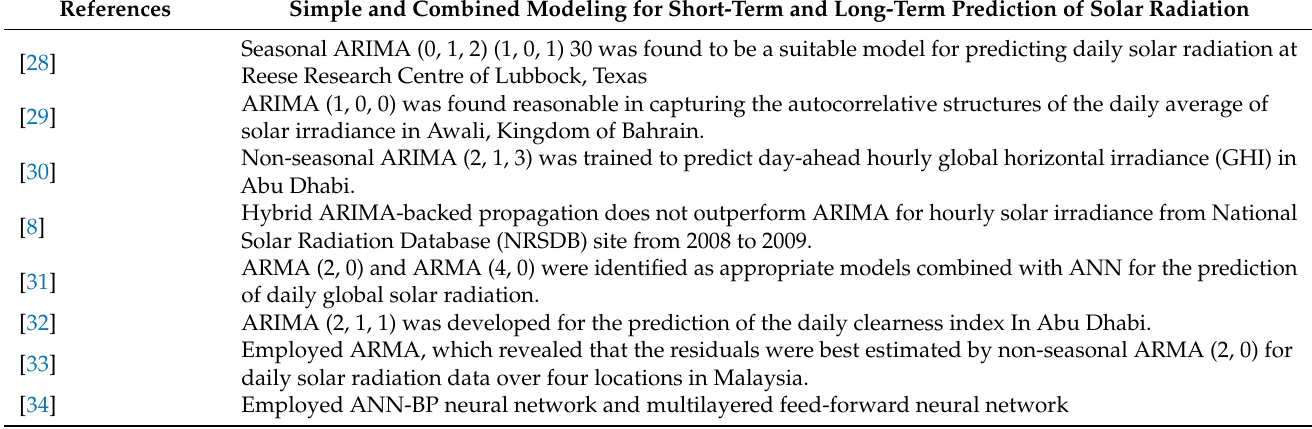
Table 1. Selected studies on ARIMA and ANN modeling of solar